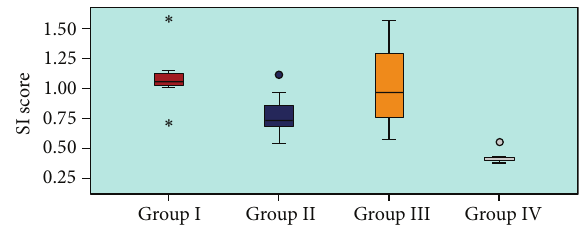
Figure 1: The histological appearances and parameters for calculat- ing the SI.